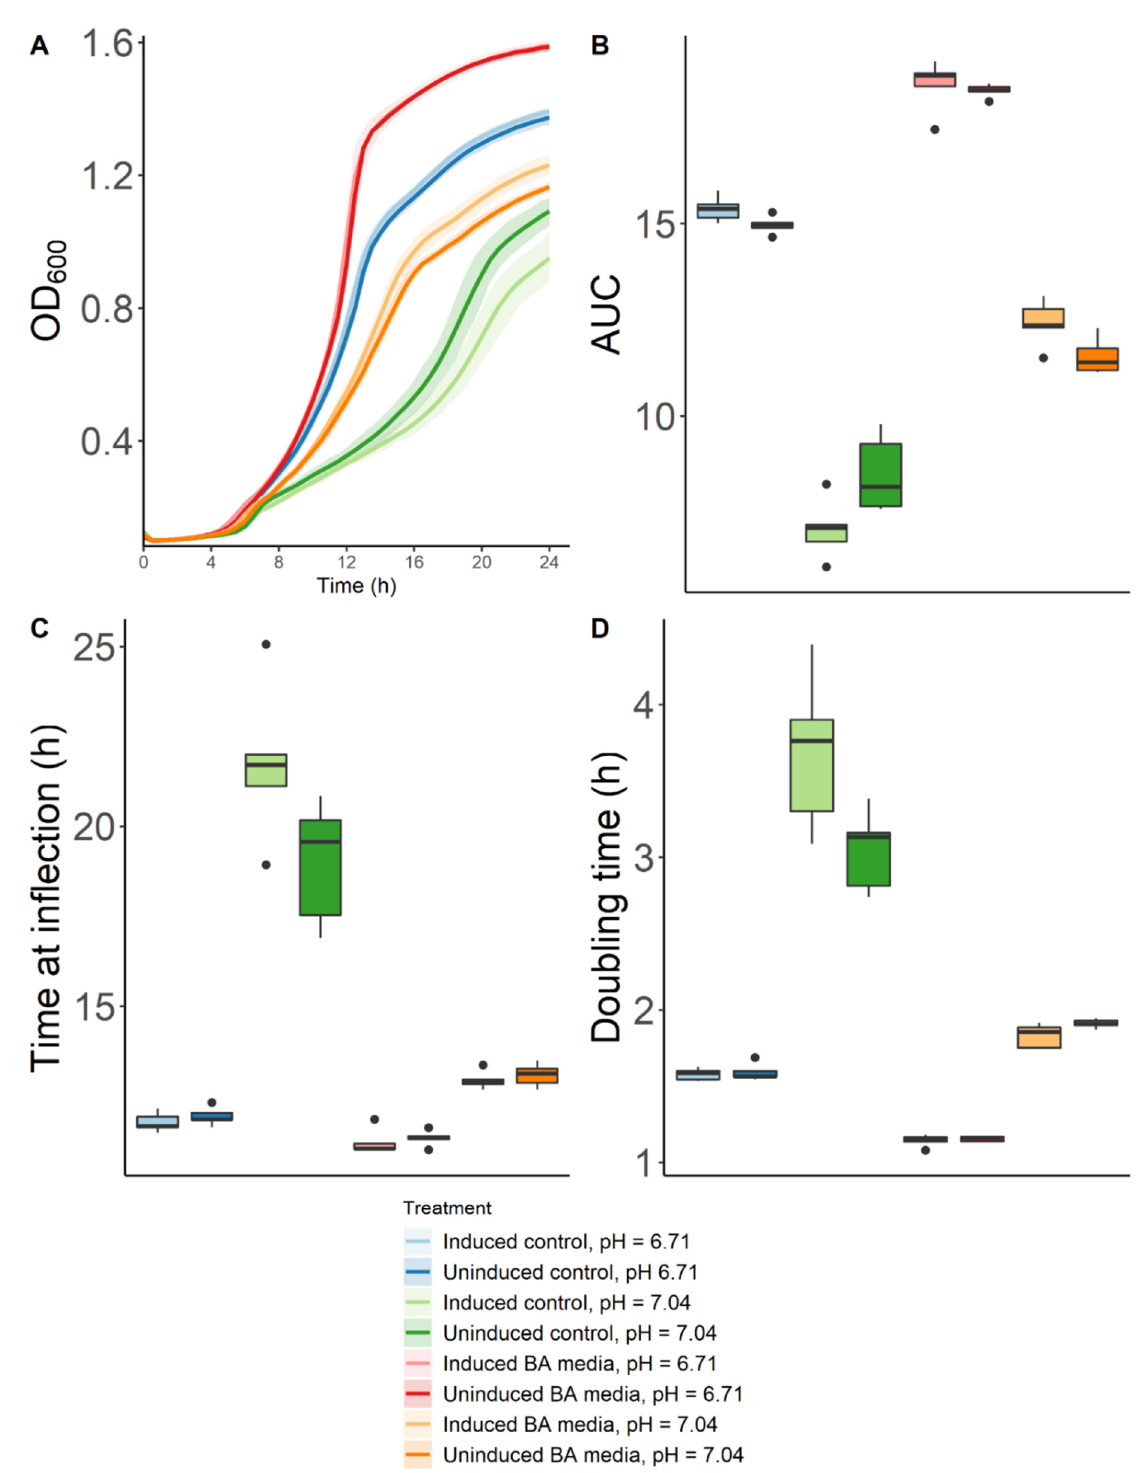
Figure 4. Effect of biogenic amines and pH on the growth of L. crispatus ATCC 33820. Data are presented as the means of 5 independent experiments. ( A ) Bacterial growth curves measured by absorbance at a wavelength of 600 nm. ( B ) Logistic areas under the curve. ( C ) Time at inflection. ( D ) Doubling times.